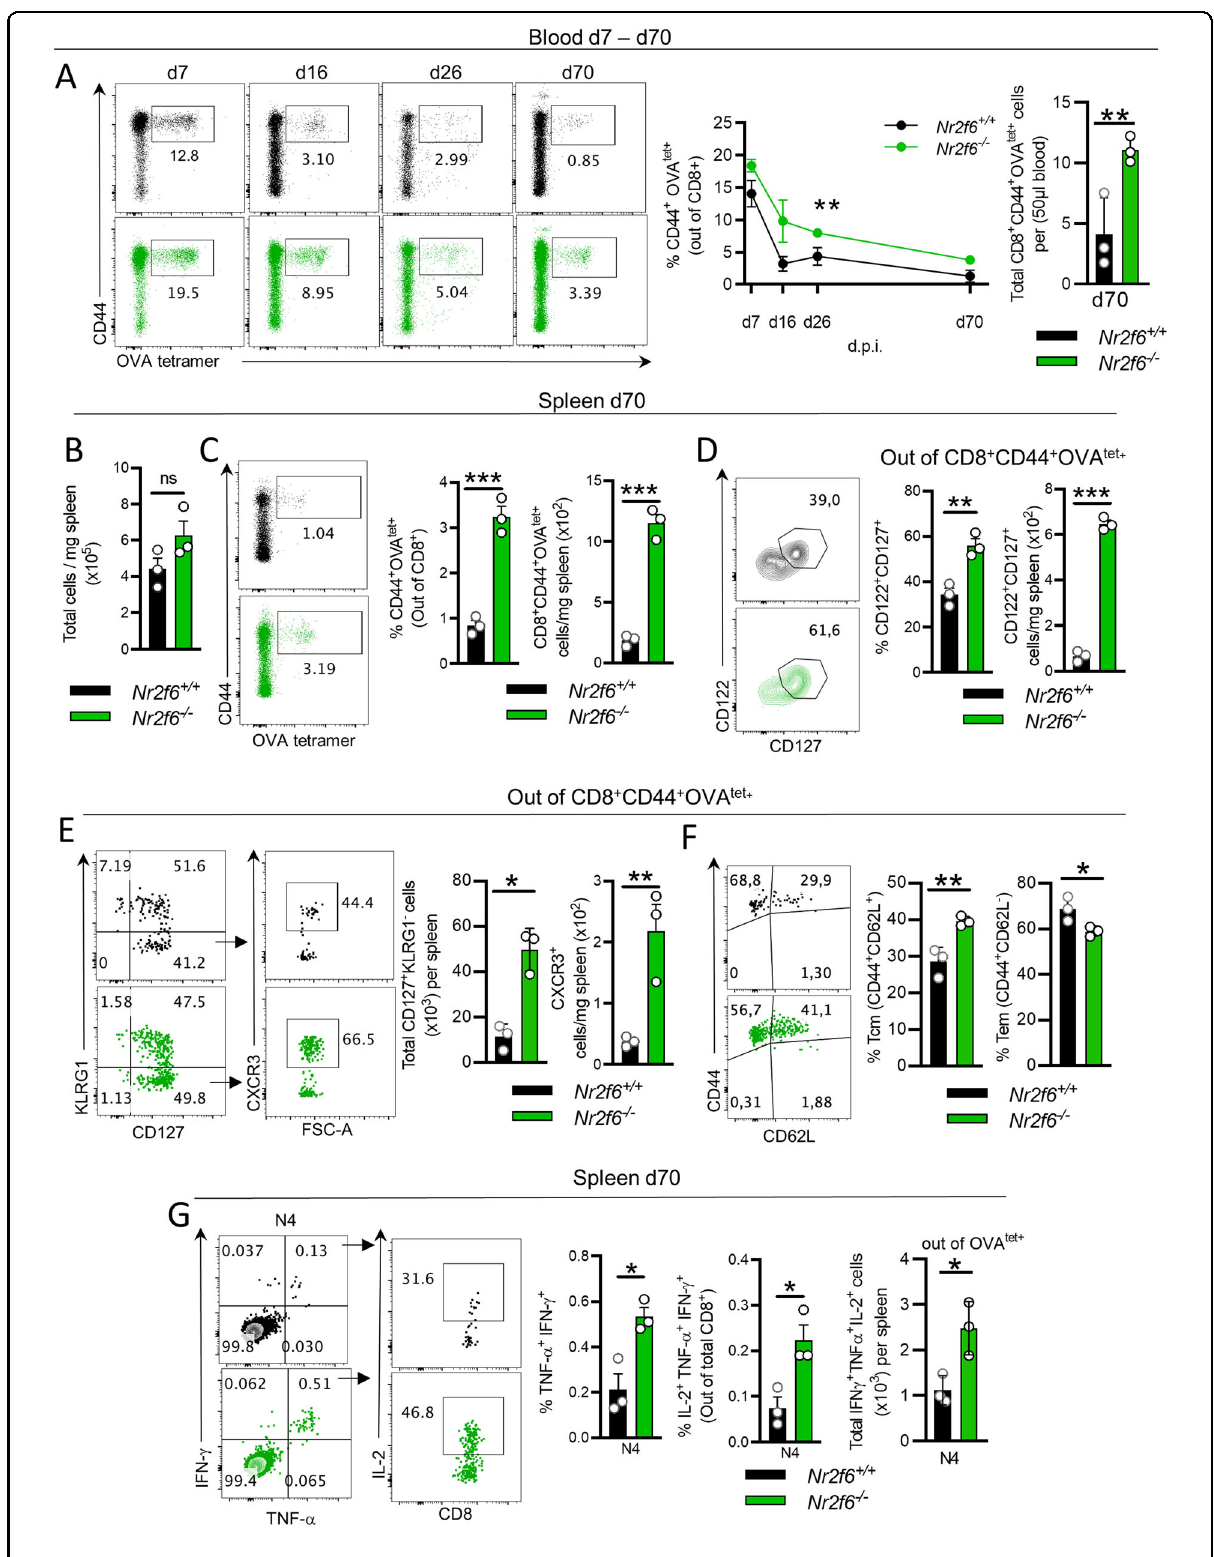
Fig. 1 (See legend on next